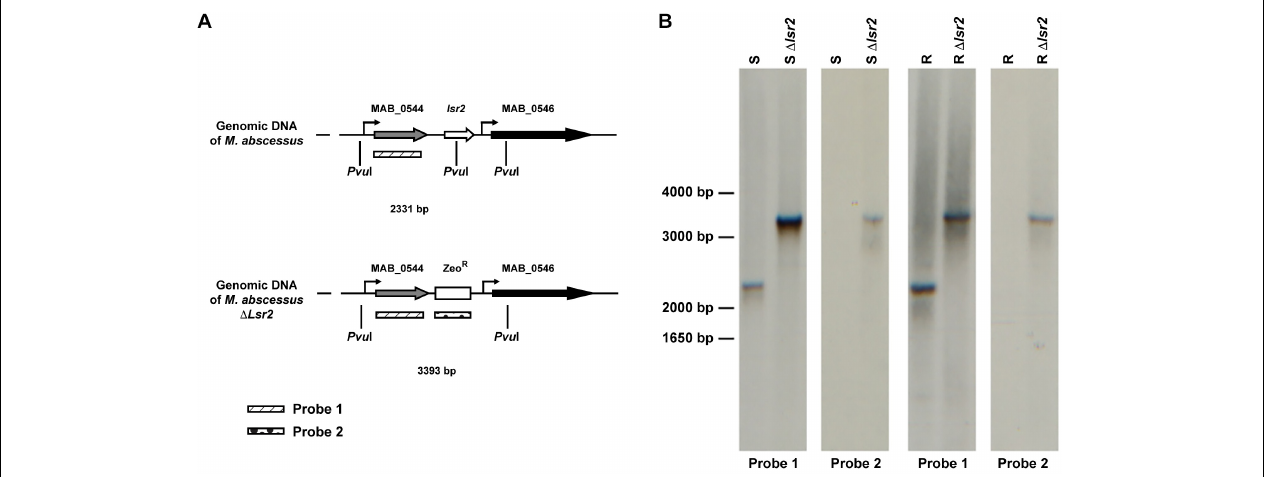
FIGURE 2 | Generation of lsr2 null mutants. (A) Schematic representation of the genomic regions surrounding the lsr2 gene in the WT and lsr2 deletion mutant. (B) Southern blot of Mabs-S (S), Mabs-R (R), Mabs-S- (cid:49) lsr2 (S (cid:49) lsr2 ) and Mabs-R- (cid:49) lsr2 (R (cid:49) lsr2 ) using Probe 1 and Probe 2 depicted in panel (A) . Genomic DNA was digested with the restriction enzyme Pvu I, migrated on an agarose gel, transferred to a nitrocellulose membrane and hybridized with the two probes. Bands of the corresponding DNA fragments observed are of the expected size.